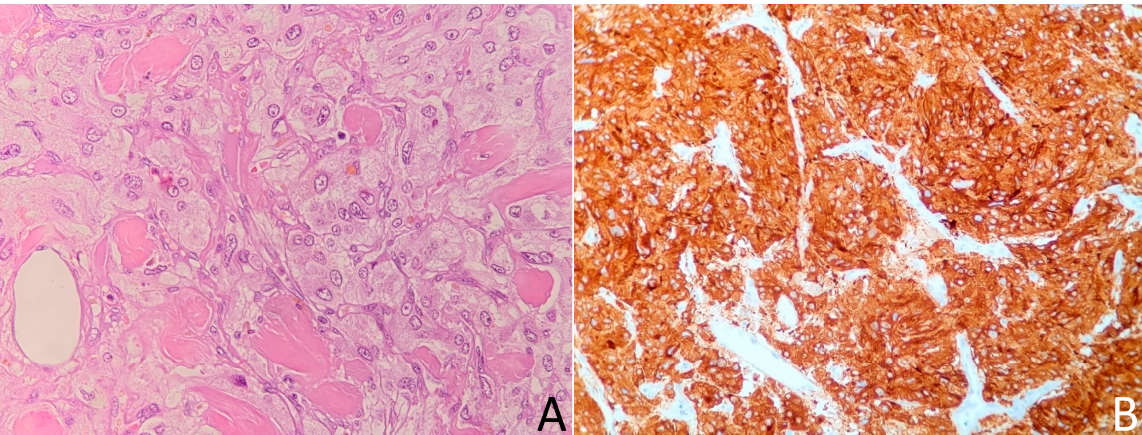
Figure 3. Pheochromocytoma. Abdomen CT, transverse cross-section.